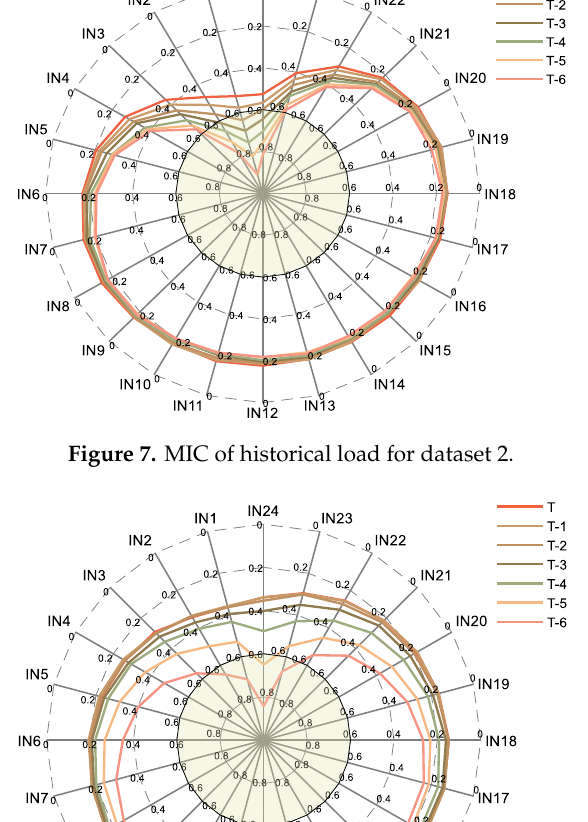
Figure 6. Maximal information coefficient (MIC) of historical load for dataset 1.